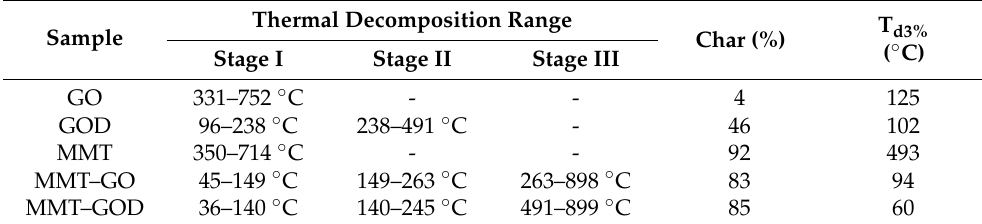
Table 3. Thermal properties for the nanoreinforcing agents.